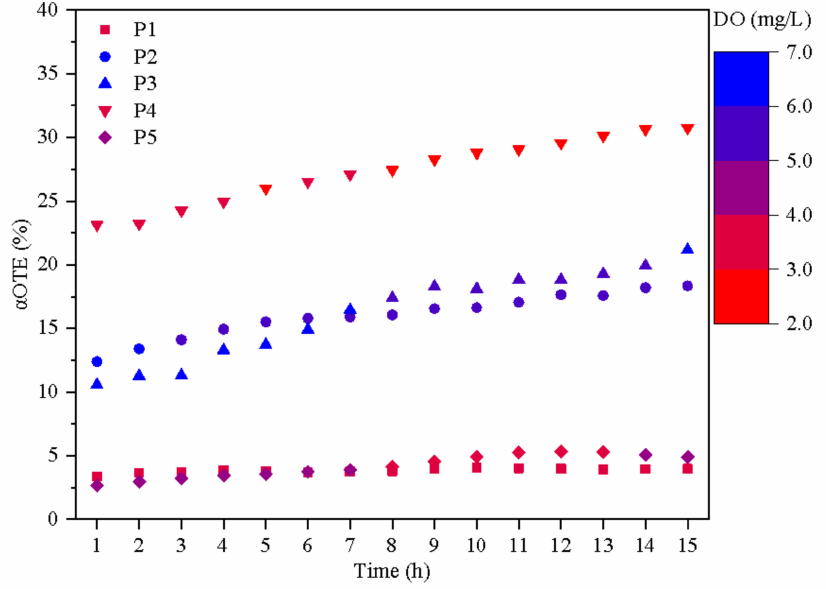
Figure 6. The α OTE of the test points during the carrier adding